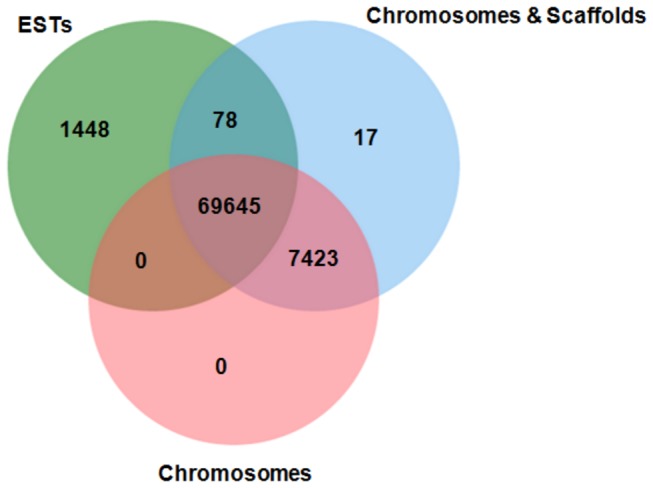
Venn diagram for sets of soybean unitags aligned* with soybean ESTs and genomic sequences**.* Via BLASTn (tolerating maximum of one mismatch).** Soybean genome browser (Phytozome database: http://www.phytozome.net/).